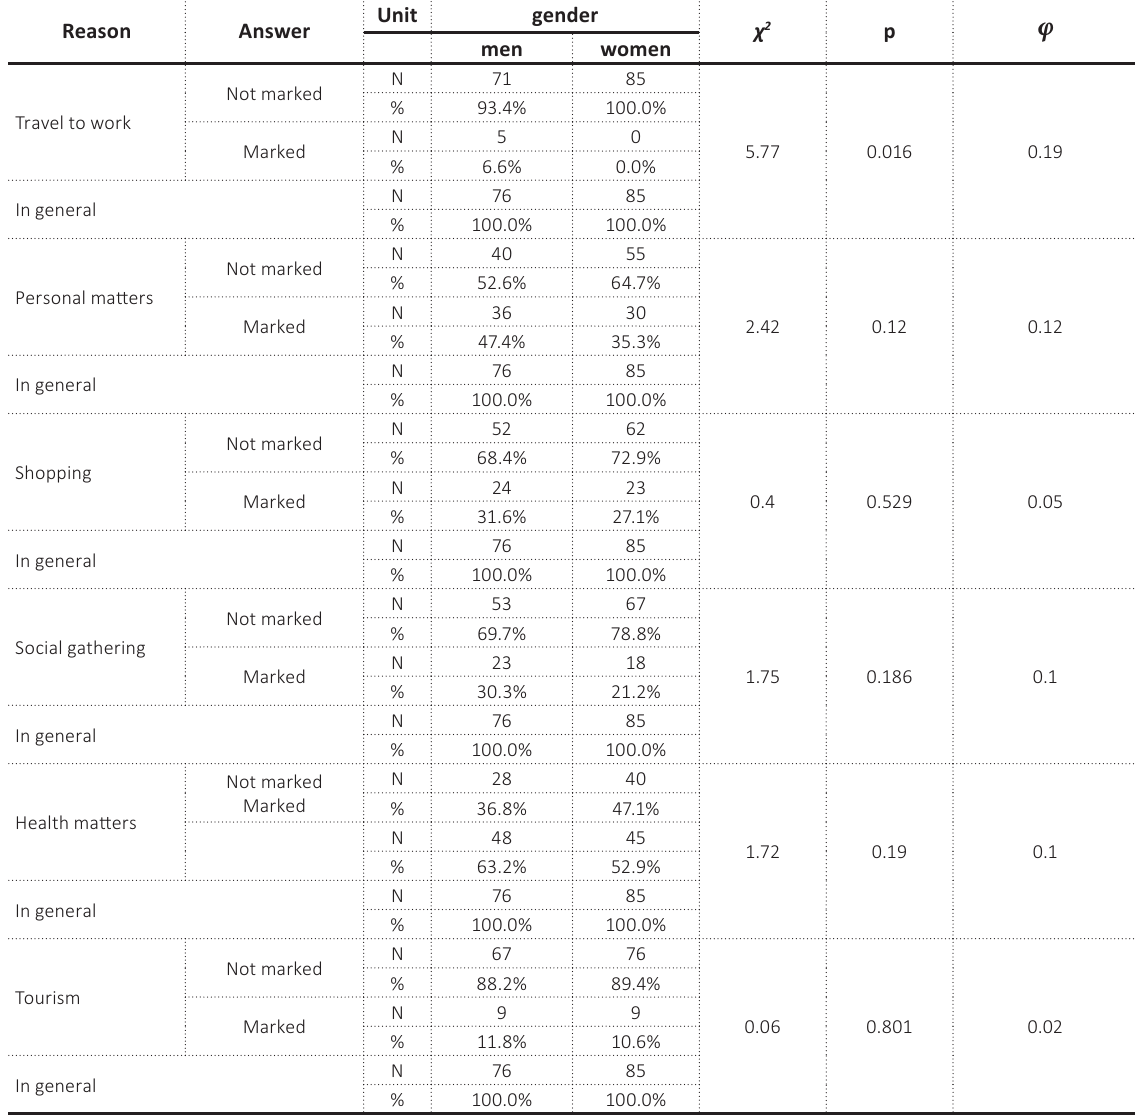
Table 1. Cross-table presenting the number and percentage of answers “For what purposes do you use collective transport (PKS)?” depending on gender